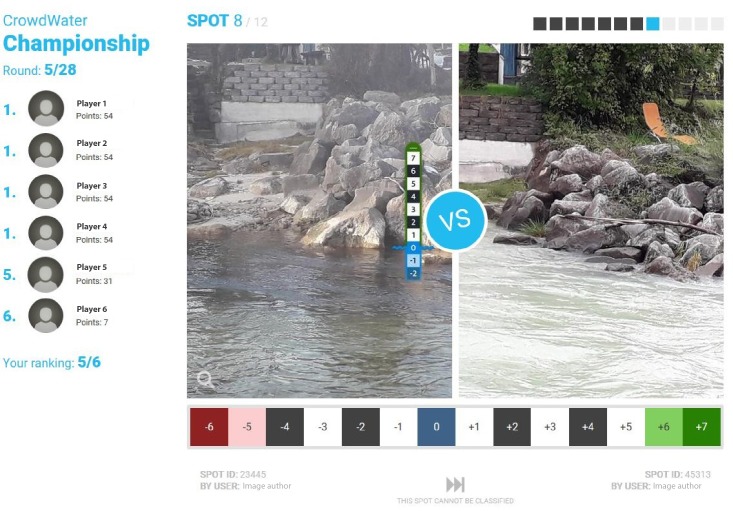
Screenshot of the CrowdWater game.The left picture shows the reference picture with the virtual staff gauge. The right picture shows an observation for the same spot at a different time. The player has to estimate the water level class for the picture on the right by comparing the water level and features in the stream or on the stream bank for both pictures. On the left hand side the scores of the top ten players for this round of the game are shown. The report button at the bottom can be used for pictures that cannot be classified. The squares at the top indicate the number of comparisons completed in this round of the game so far (black) and comparisons still to come (grey).